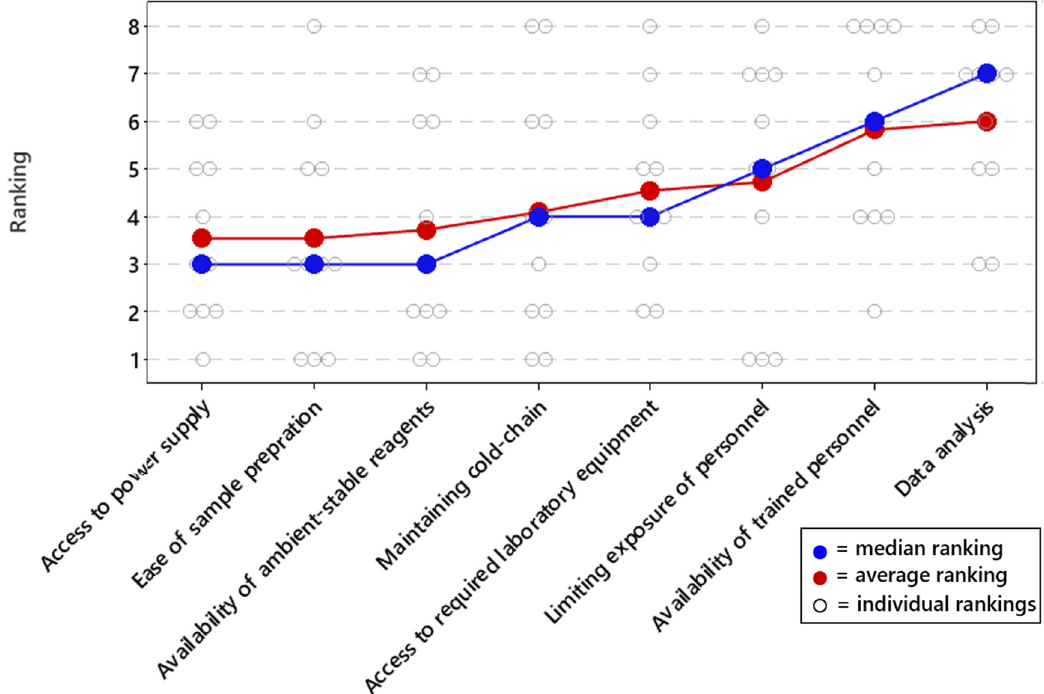
Figure 3. Challenges for field-forward biodetection applications. Respondents ranked all challenges on a priority scale of 1 to 8, with 1 being the most important and 8 being the least important issue to overcome. The average and median rankings for each performance metric are provided in Figure 3, as well as each individual response. Average and median rankings are based on responses from n = 11 respondents.